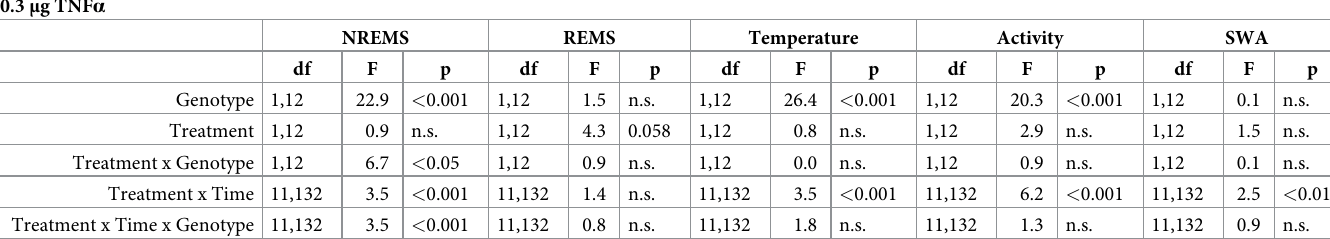
Table 1. Non-rapid-eye movement sleep (NREMS), rapid-eye movement sleep (REMS), body temperature, motor activity and electroencephalographic slow-wave activity (SWA) after 0.3 μg TNF α administration: Statistical